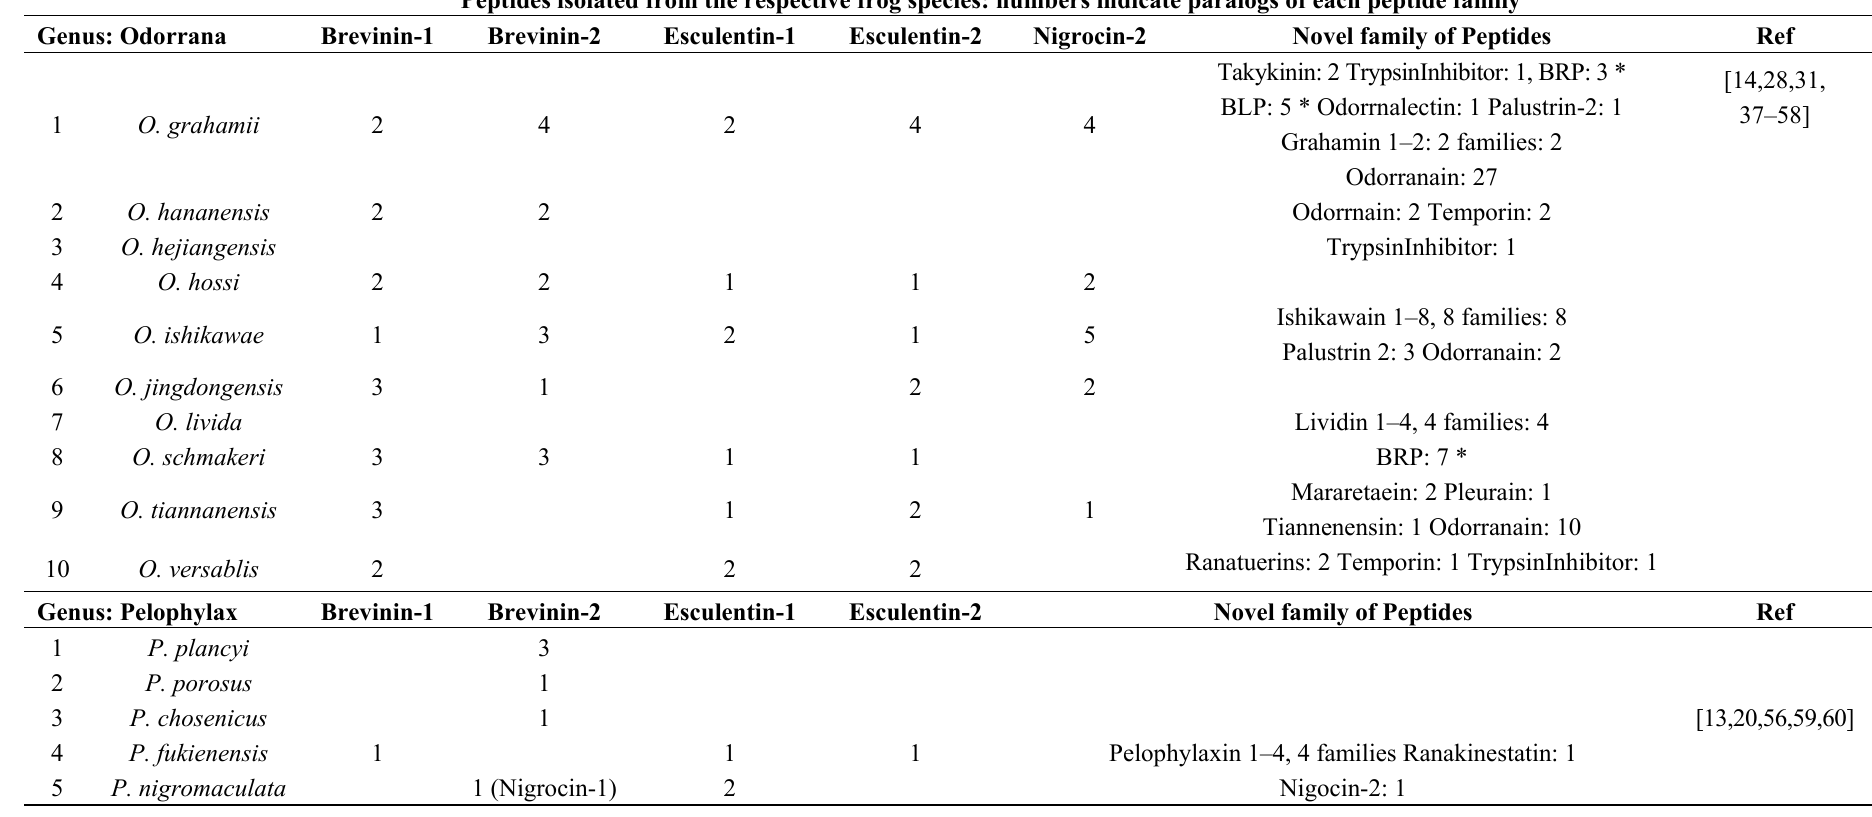
Table 1. Cont . Peptides isolated from the respective frog species: numbers indicate paralogs of each peptide